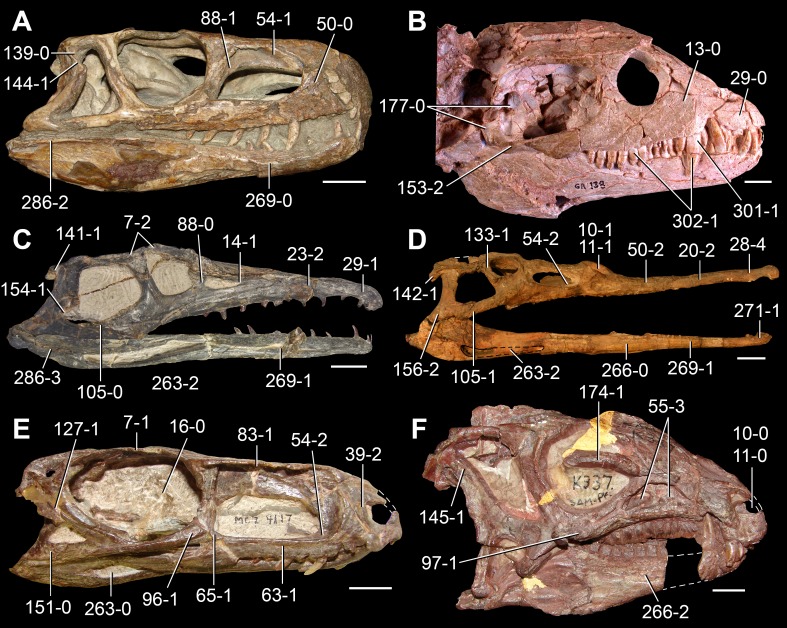
Skulls of Triassic and Early Jurassic archosauriforms in lateral view.(A) Euparkeria capensis (SAM-PK-5867); (B) Vancleavea campi (USNM 508519 [cast of GR 138]); (C) Gualosuchus reigi (PVL 4576); (D) Parasuchus hislopi (ISI R42, mirrored); (E) Gracilisuchus stipanicicorum (MCZ 4117); and (F) Heterodontosaurus tucki (SAM-PK-K337). Numbers indicate character-states scored in the data matrix and anterior direction is towards the right. Scale bars equal 1cm in (A, B, E, F), 2 cm in (C), and 5 cm in (D). Photograph (B) courtesy of Sterling Nesbitt.